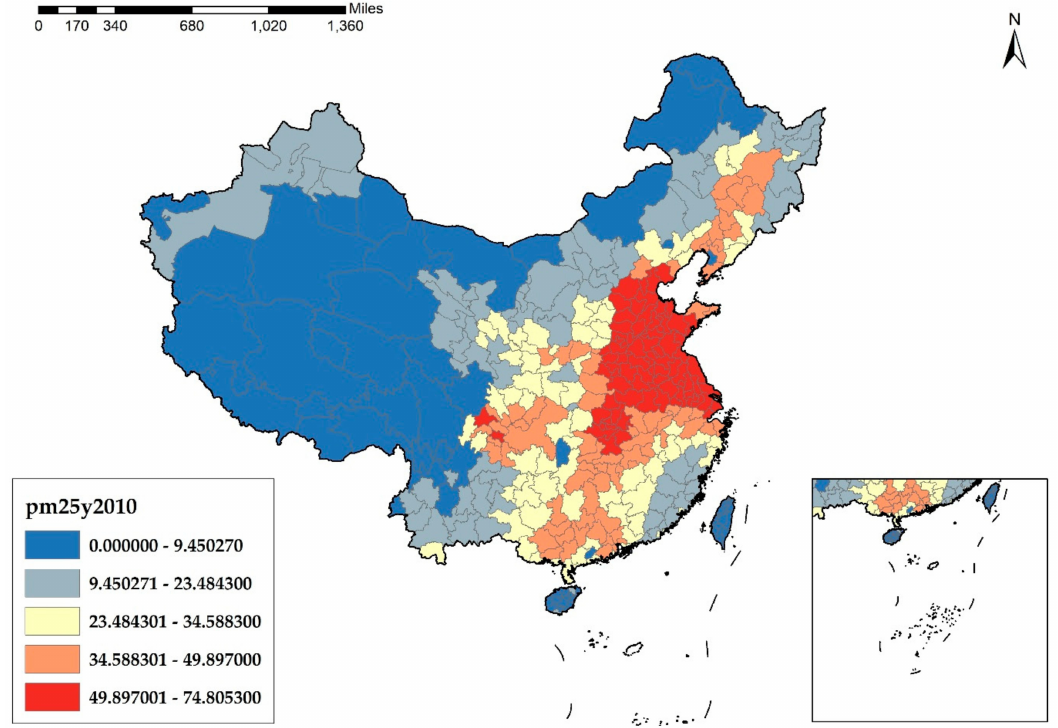
Figure 3. PM 2.5 Concentration at the city level in China in 2010 ( µ g / m 3